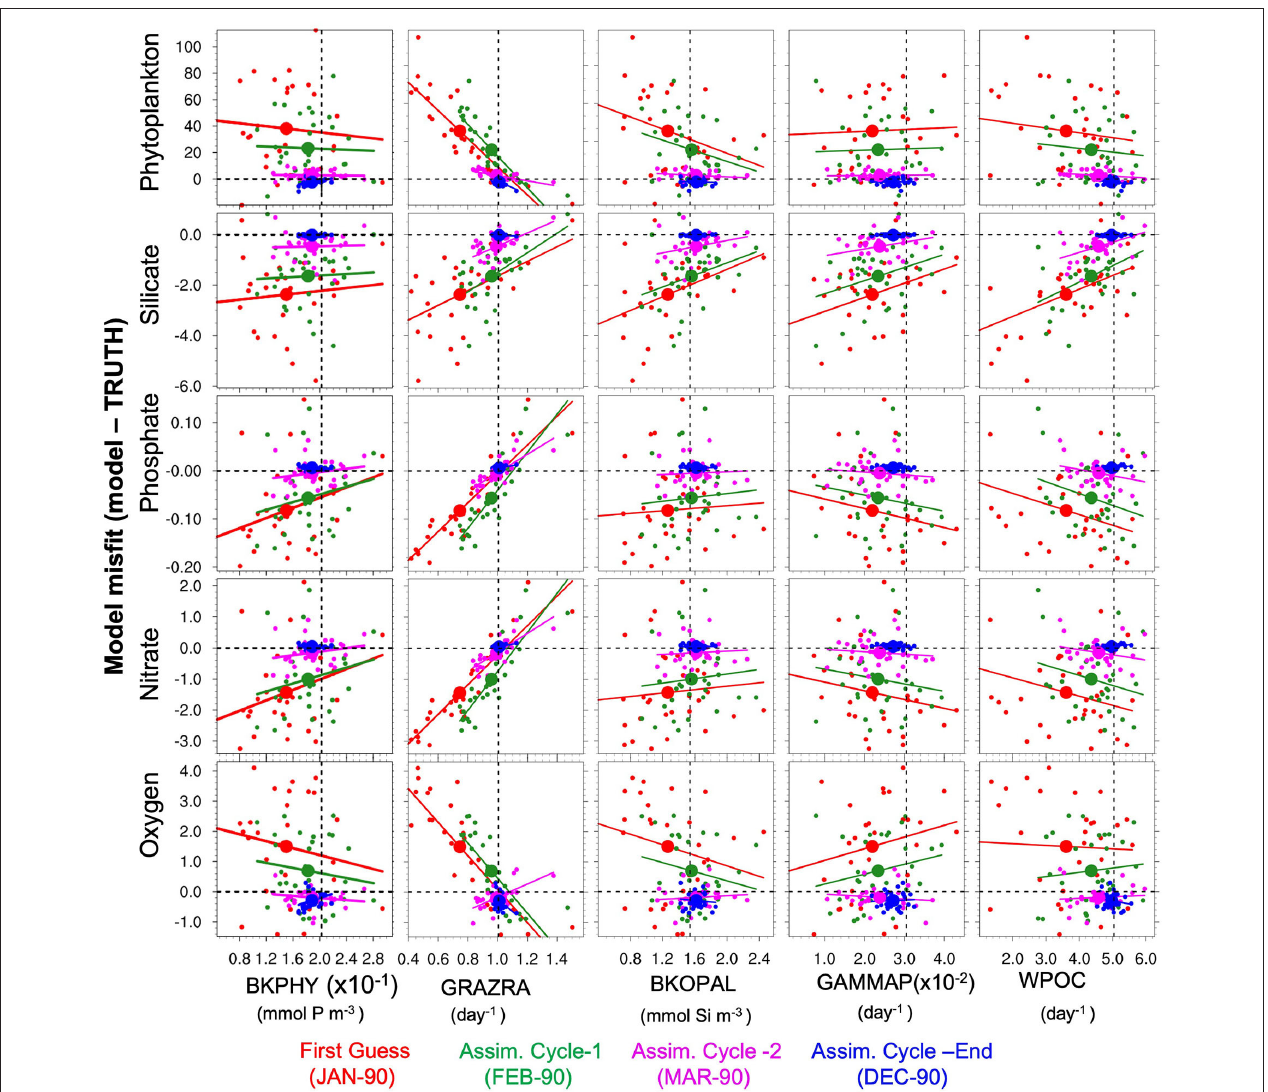
FIGURE 5 | Scatter plots for globally-averaged misfit (model-TRUTH) ensemble vs. BGC parameters ensemble. Plots are shown for surface phytoplankton (row-one), silicate (row-two), phosphate (row-three), nitrate (row-four), and oxygen (row-five) with BKPHY (column-one), GRAZRA, (column-two), BKOPAL (column-three), GAMMAP (column-four), and WPOC (column-five) parameters; obtained from first guess (red), after first assimilation cycle (green), second assimilation cycle (purple), and end of assimilation (blue) with EnKF_PE experiment. The large dots show the ensemble mean. Horizontal and vertical dashed black reference lines represent the line of zero misfit and global-averaged TP values, respectively. Solid colored lines are the linear regression